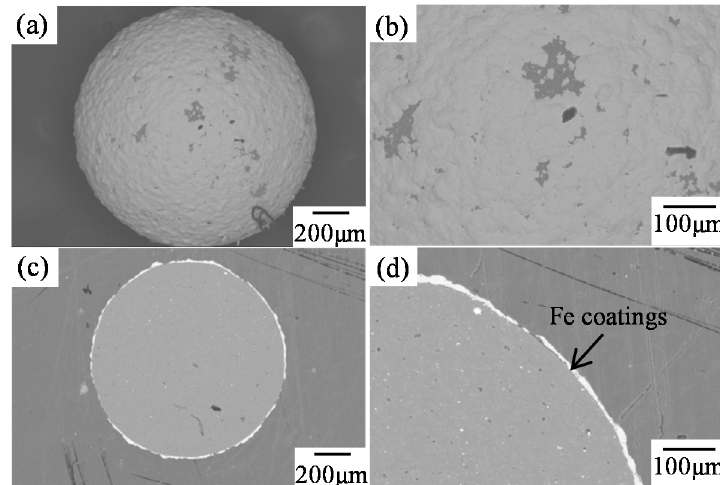
Figure 10. Fe coatings by MCT at 300 rpm for 26 h. ( a , b ) Surface structure; ( c , d ) Cross sectional structure.